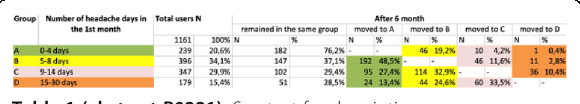
Table 1 (abstract P0221). See text for